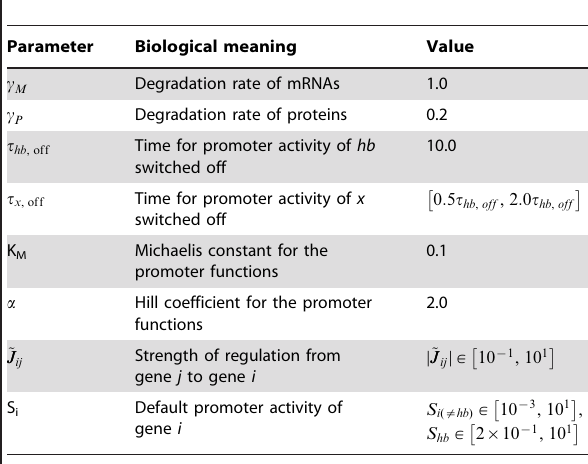
Table 4. Parameter values used for continuous dynamics of the genetic